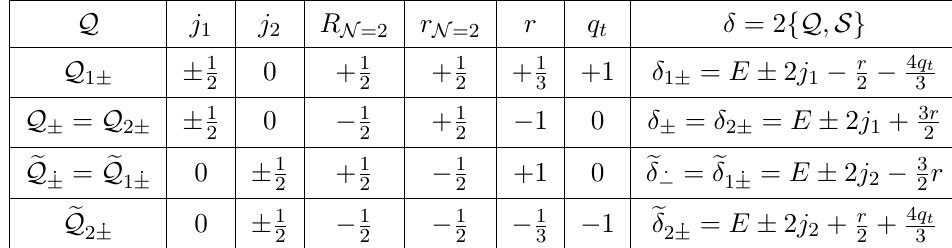
Supercharges of the su (2 , 2 | 2) superalgebra and its su (2 , 2 | 1) subsuperalgebra. The orbifold breaks su (2 , 2 | 2) −→ su (2 , 2 | 1) ⊕ u (1) radial quantisation S = Q †